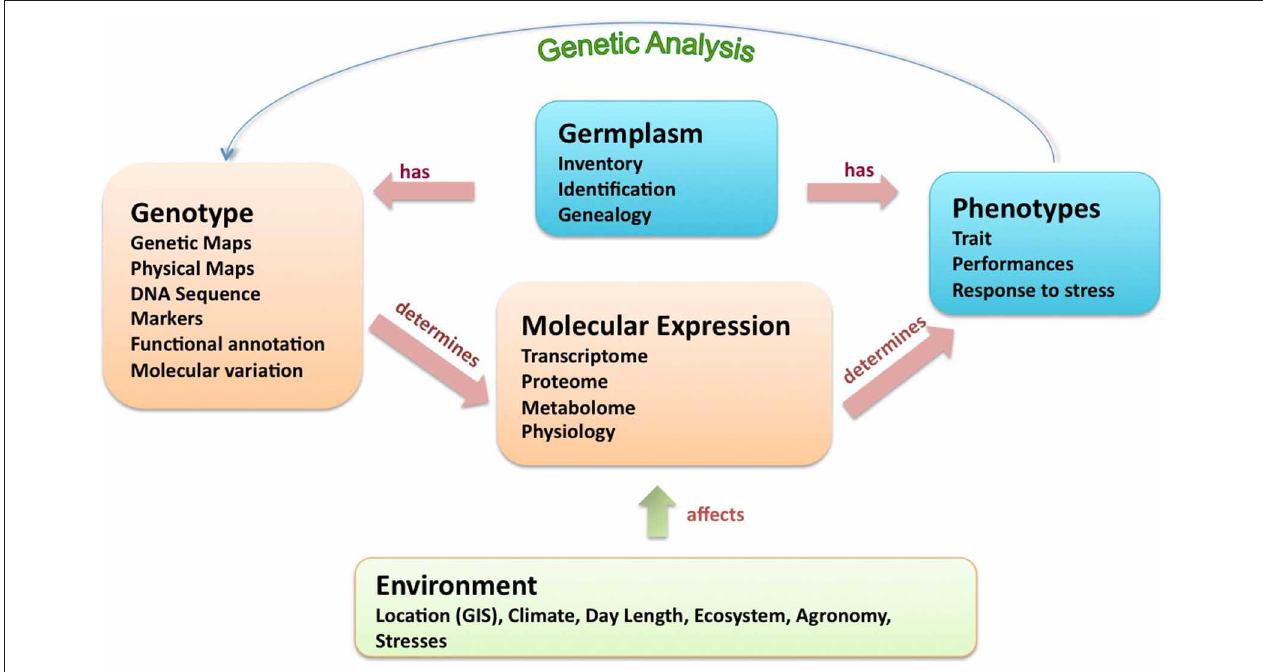
FIGURE 1 | Biological relationships in germplasm research adapted from Bruskiewich et al. (2006).